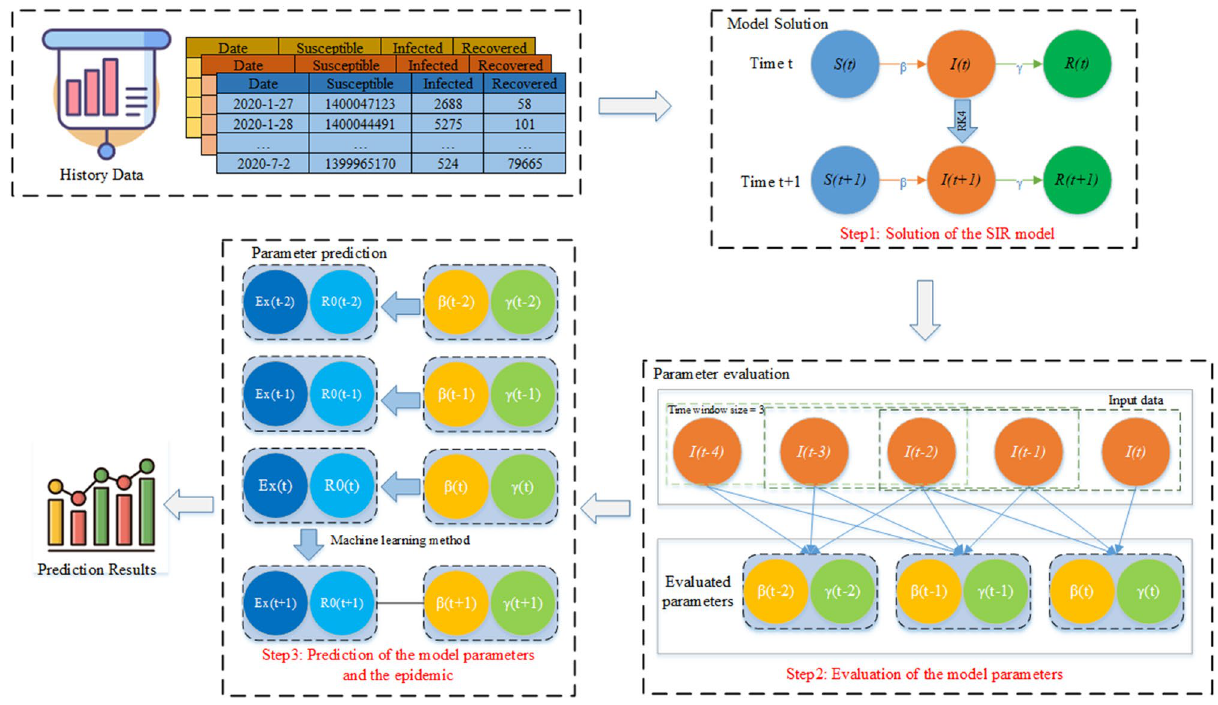
Figure 1. The main workflow of the TW-SIR